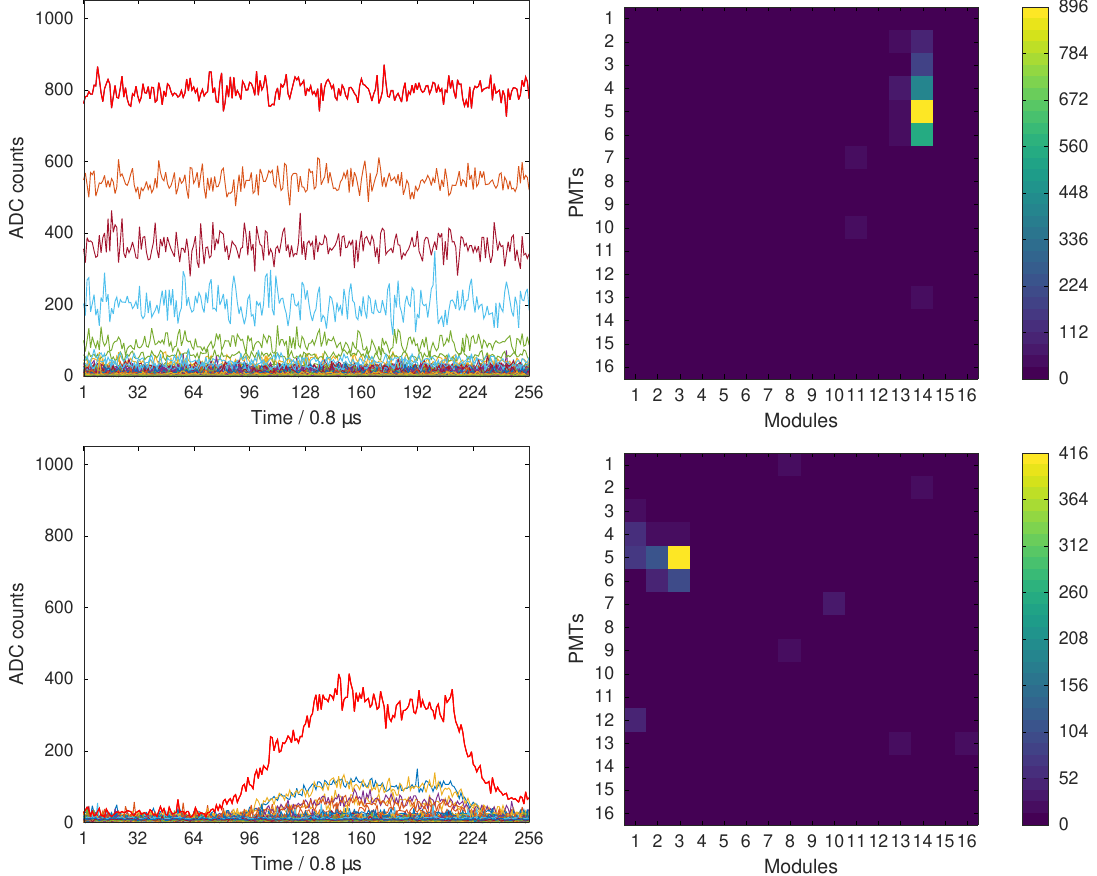
Figure 12. Examples of events that were mistakenly classified by the CNN as instant TLFs. Interestingly, neither increasing the amount of data used for a description of every TUS event, nor a few modifications of the CNN lead to an improvement of the accuracy of classification. Even CNNs employing all available ADC codes in events used for training demonstrated lower accuracy on the testing sample than the CNN employing 768 numbers. They were sometimes confused by events in which the peak of the signal was